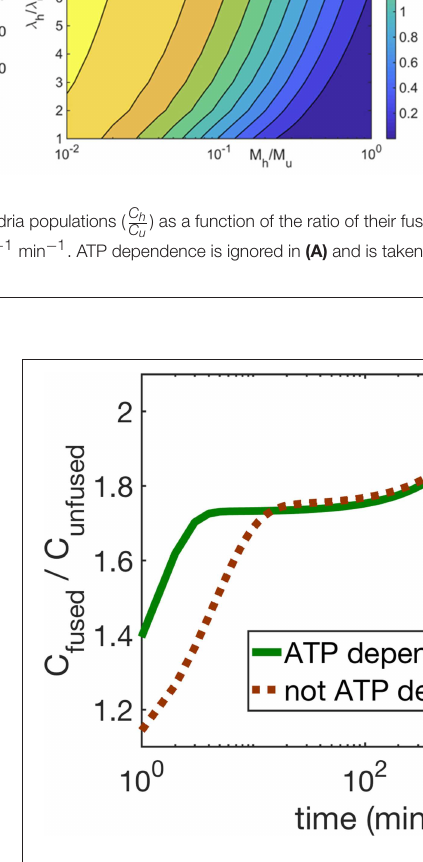
FIGURE 4 | The time evolution of mitochondria population concentrations; ATP dependence is taken into account. Inset shows the time evolution of ATP concentration. The phenomenological parameters for ATP generation and use are as follows. σ cell = 3 for all data shown here. Open symbols correspond to γ = 1.87 Mito − 1 min − 1 , µ = 1.43, i.e., healthy and fused mitochondria